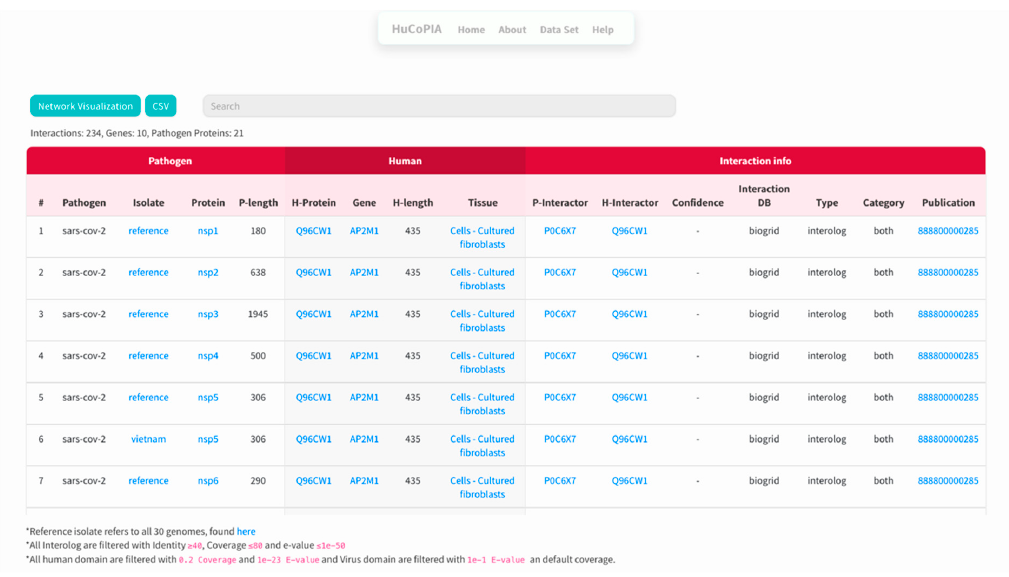
Figure 3. A snapshot of the results page of HuCoPIA. Figure 3. Network visualization of HPIs between ten genes and